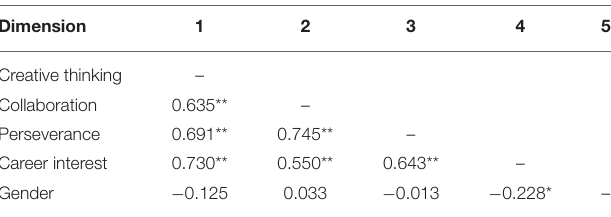
TABLE 3 | Results of correlation test for the main variables.